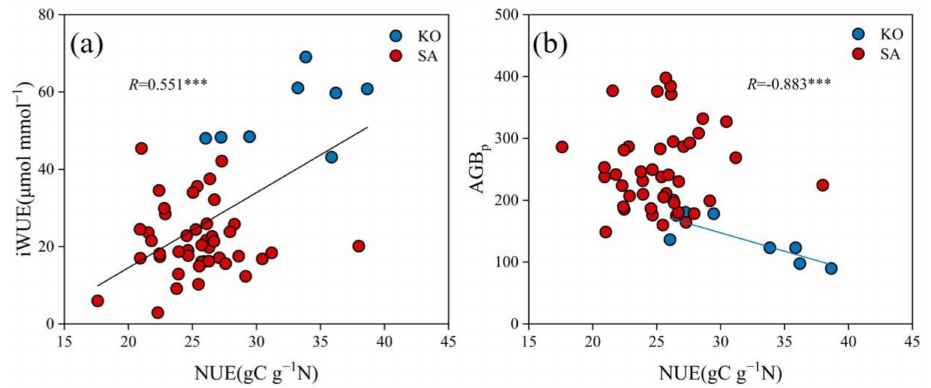
Figure 6. The relationships between NUE and iWUE ( a ), and NUE and AGB p ( b ) in two dominant mangrove species of the Qi’ao mangrove forest. KO: Kandelia obovate ; SA: Sonneratia apetala ; *** means p < 0.001; AGB p was derived from the published data in